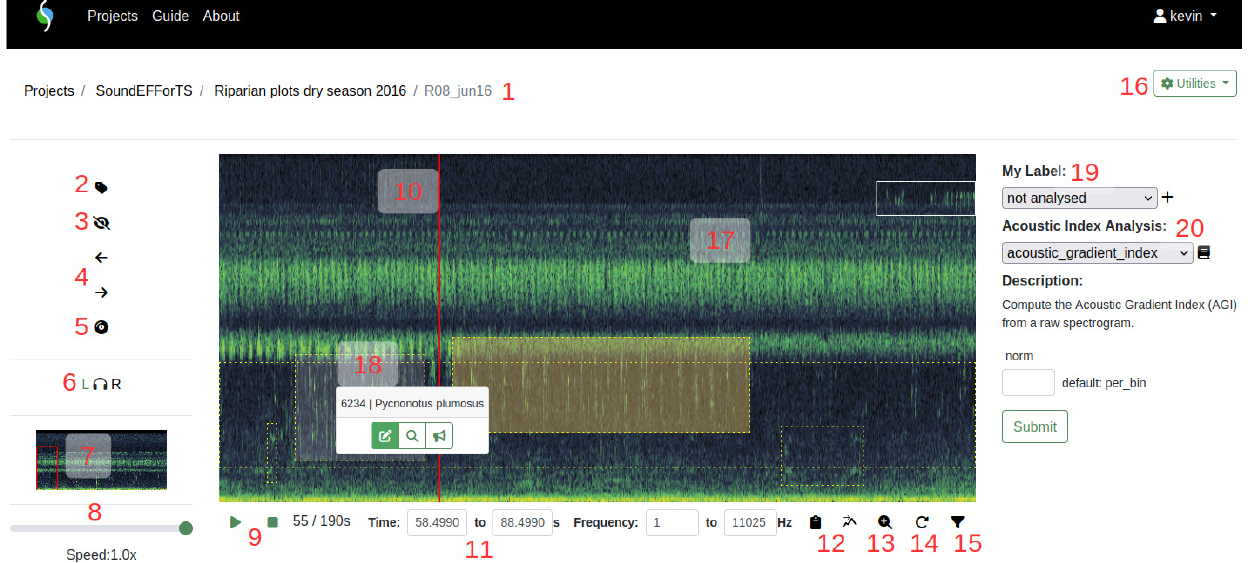
Figure 4. ecoSound-web spectrogram player.ecoSound-web spectrogram player. Numbers correspond to the following sections: 1: Project/collection/sound name. 2: annotating (i.e., tagging) sounds. 3: hiding/showing tags. 4: panning spectrogram left and right 5: playback mode (zoom to standardised display density). 6: audio channel selection. 7: overview spectrogram, red rectangle shows current view. 8: playback speed slider. 9: playback/ pause and stop, time position. 10: playback cursor. 11: time and frequency coordinates of current view or selection. 12: two analysis buttons: copying time and frequency coordinates, exporting frequency of maximum energy. 13: zooming into current selection. 14: continuous playback. 15: frequency filter. 16: utilities menu, containing: image and audio download, FFT window size setting, file info. 17: tags of different users shown with different colors; reviewed tags with solid border, not yet reviewed tags with dashed border; tags without detection distance with orange shading. 18: tag ID and species/sound type appear on click, with buttons for editing, zooming, and estimating